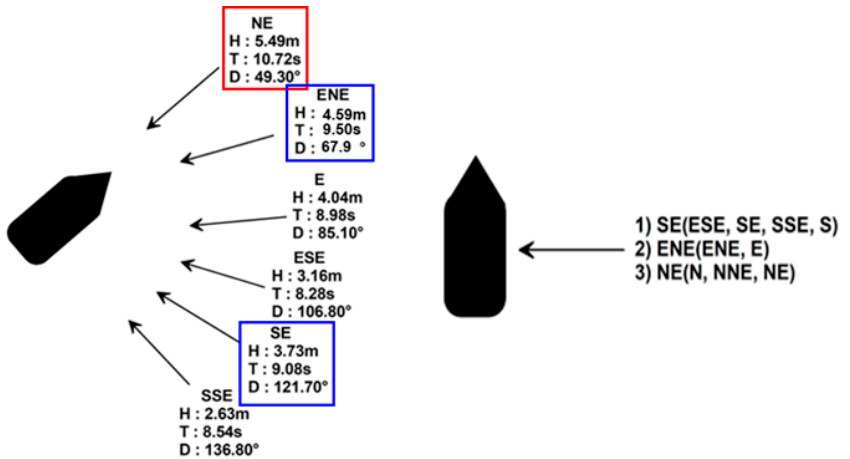
Figure 6. Wave height and periods according to the installation direction of the sunken vessel artificial reef and wave directions. Table 6. The maximum dynamic wave pressure according to water depth.